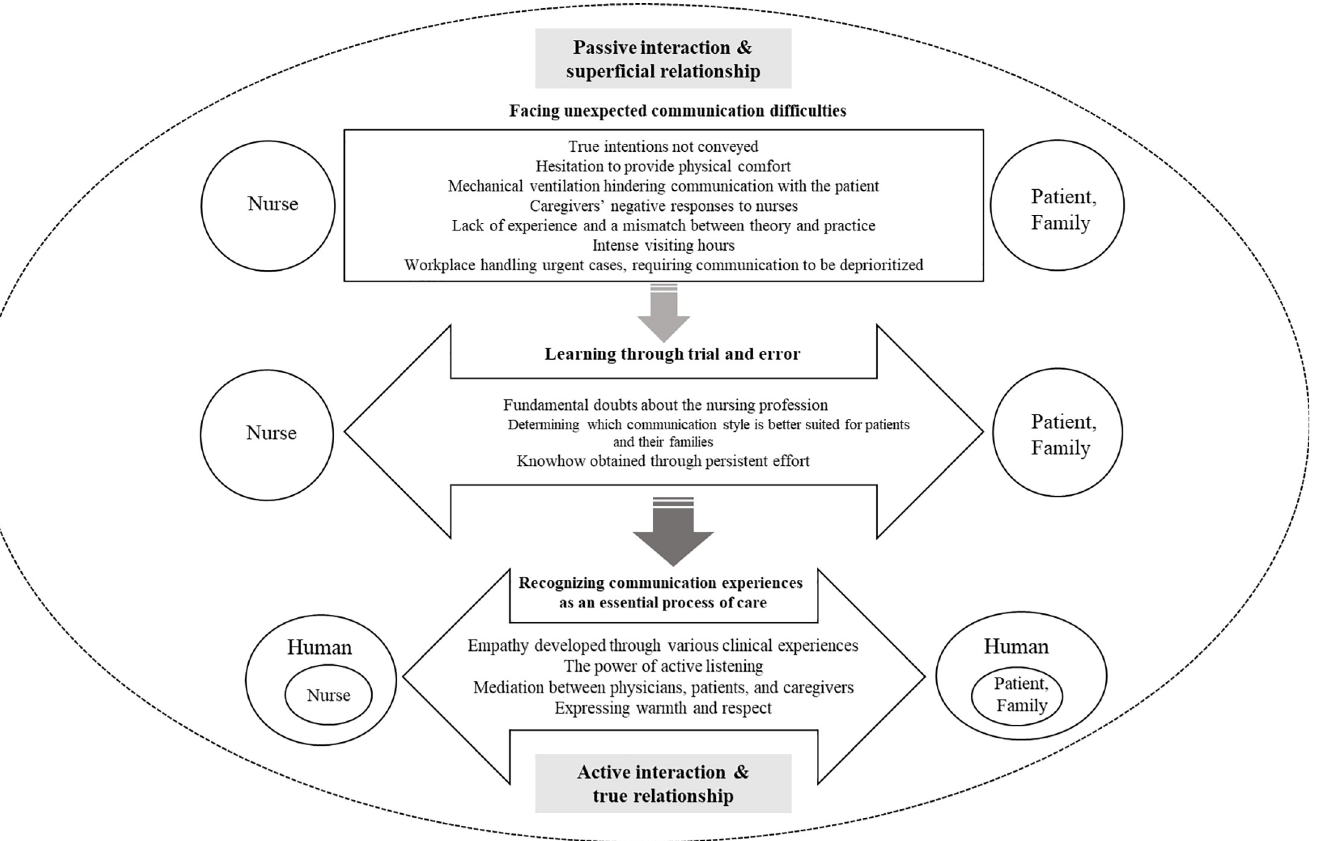
Fig 1. Summary of communication experiences encountered by intensive care unit